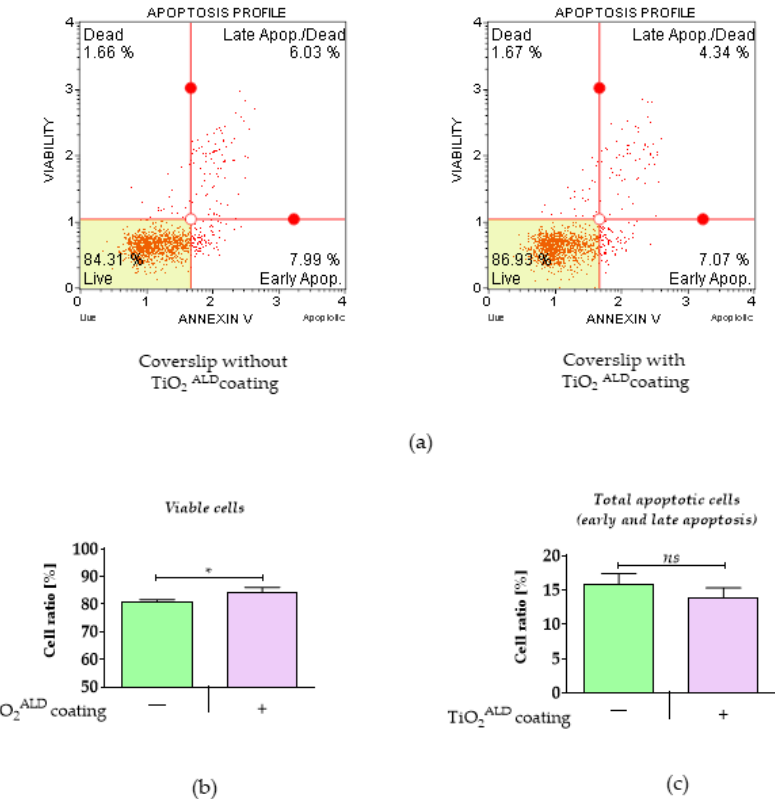
Figure 5. The cell viability and apoptosis profile in the control culture (TiO 2 ALD coatings-) and the culture propagated on TiO 2 coatings (TiO 2 ALD coatings + ; experimental culture): ( a ) representative graphs obtained during analysis, showing the distribution of cells on four populations: live (Live—bottom-left corner), early apoptotic (Early Apop.—bottom-right corner), late apoptotic (Late Apop. / Dead—upper-right corner), and dead (Dead—upper-left corner); results of statistical analysis showing a comparison of viable cells ( b ) and apoptotic cells ( c ) in control and experimental cultures (significant differences are marked with asterisks (* p < 0.05), non-significant results are marked as ns).